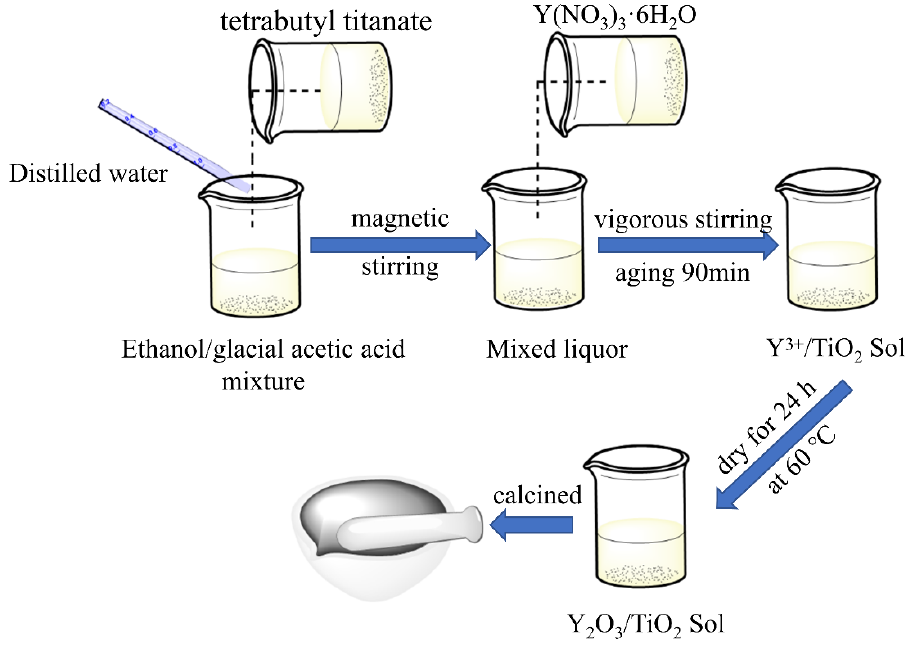
Figure 1. Schematic diagram of the Y 2 O 3 /TiO 2 preparation